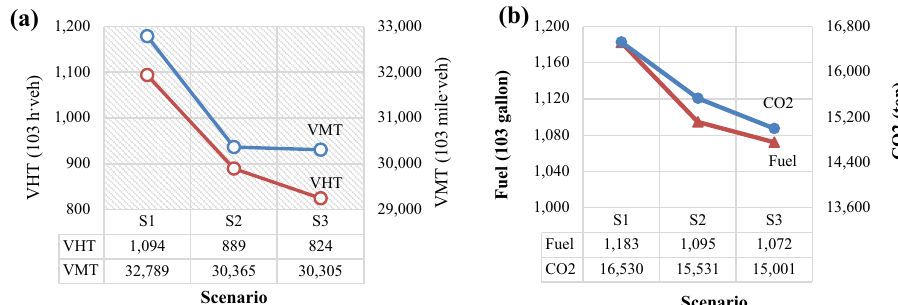
Fig. 7 a VMT and VHT by scenario; b fuel